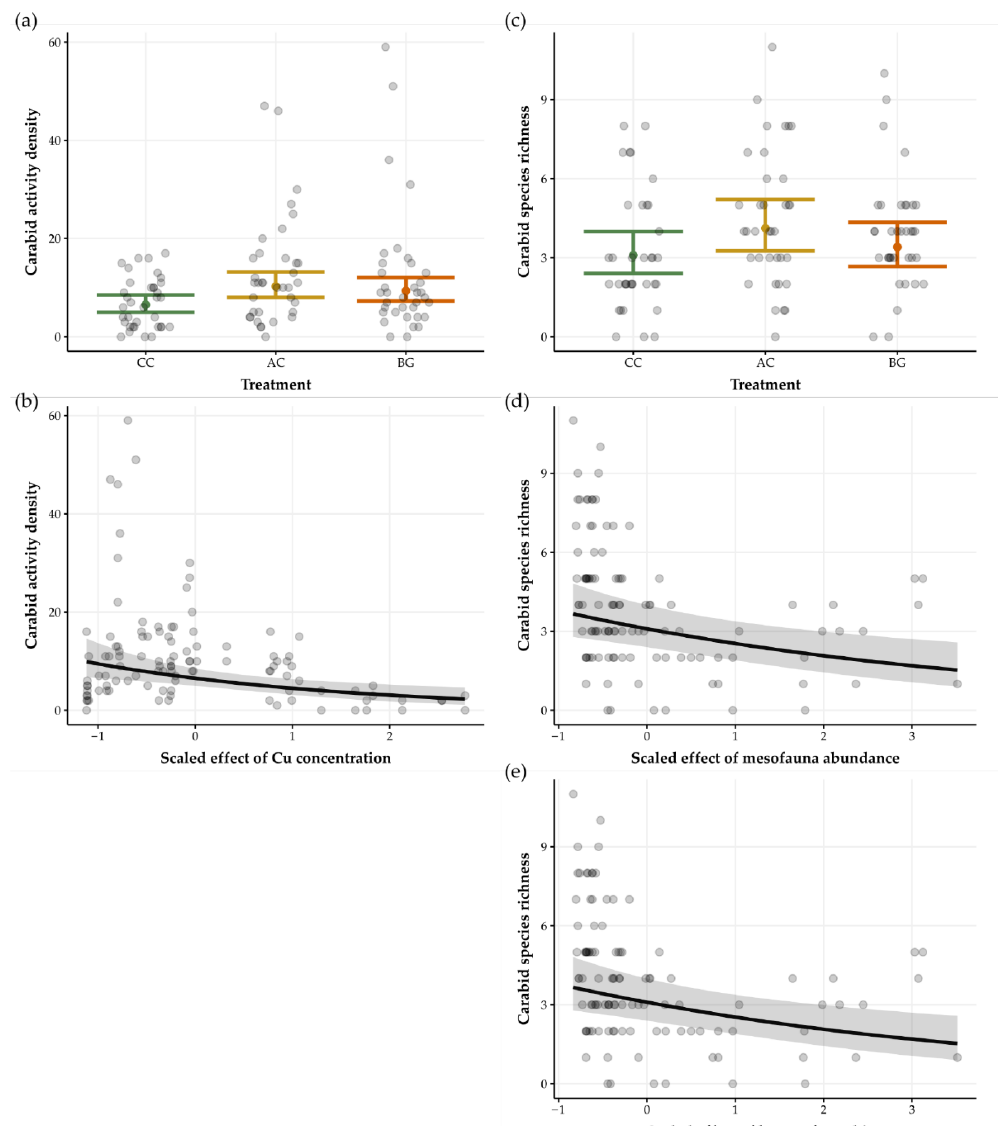
Figure 5. The observed and predicted carabid activity density and species richness in relation to ( a , b ) treatment, ( c ) carabid activity density to scaled copper concentration and carabid species richness to ( d ) scaled mesofauna abundance and ( e ) scaled hours of sunshine. As a categorical variable, the mean value of each treatment is represented by the center point with the 95% confidence interval bars, with complete vegetation cover (CC) as the baseline model intercept, and alternating vegetation cover (AC) and bare ground by tillage (BG) as additions thereafter. The solid lines of the continuous variables represent the predicted model with all other variables held constant, with 95% confidence intervals in grey.